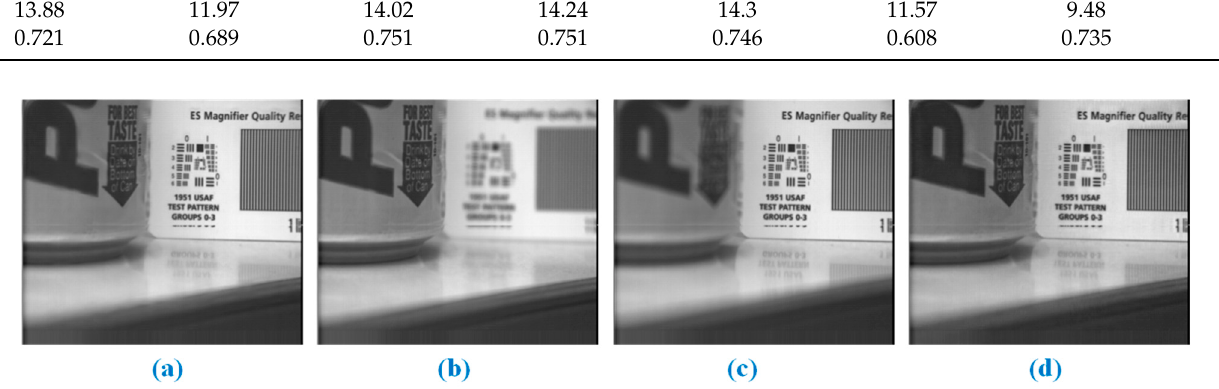
Table 34. The outcomes for the pepsi image and comparisons with existing techniques in the litera- ture ([25]). Evaluation Metric